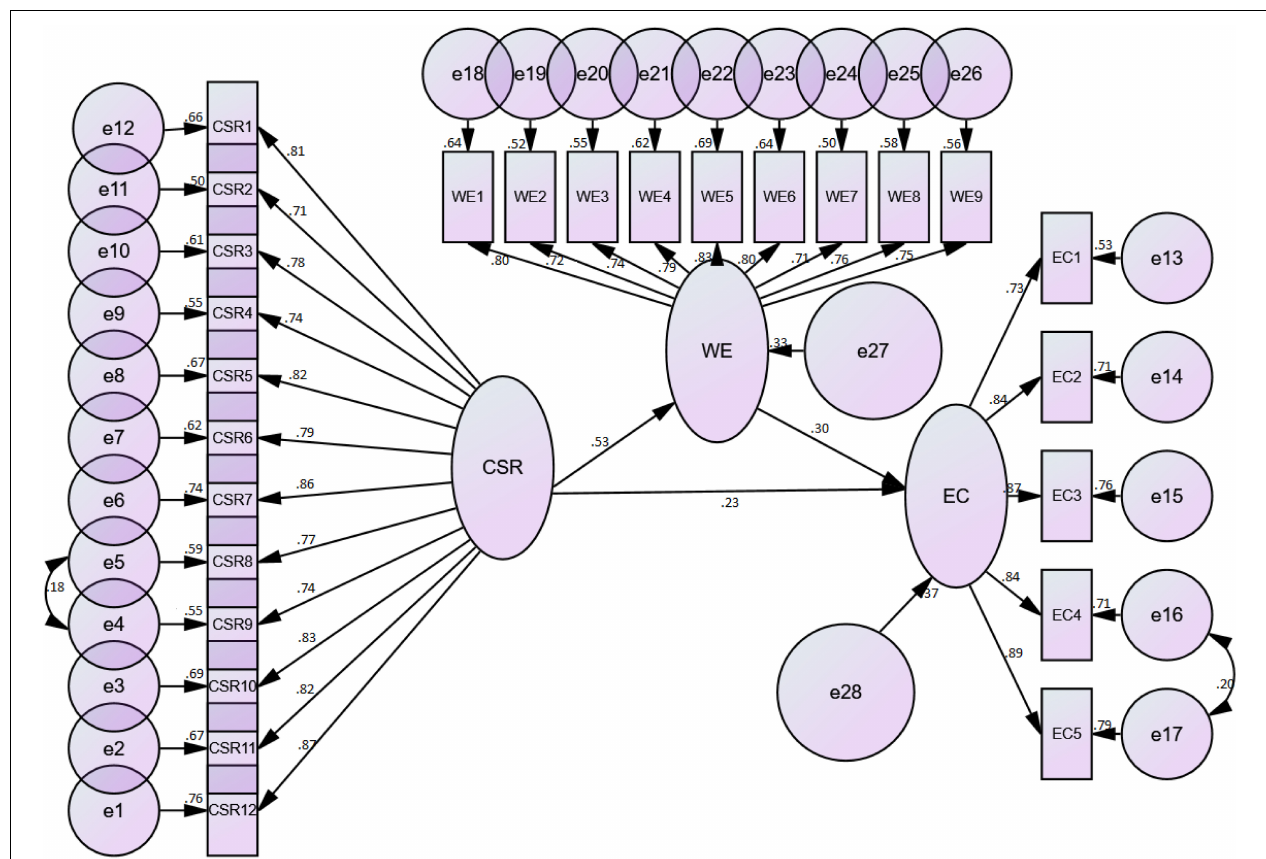
FIGURE 1 | Presents the structural model of the hypothesized